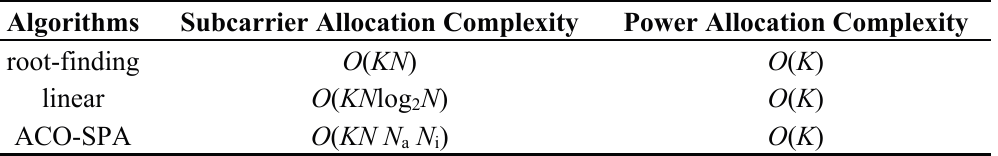
Table 3. The comparison of the computational